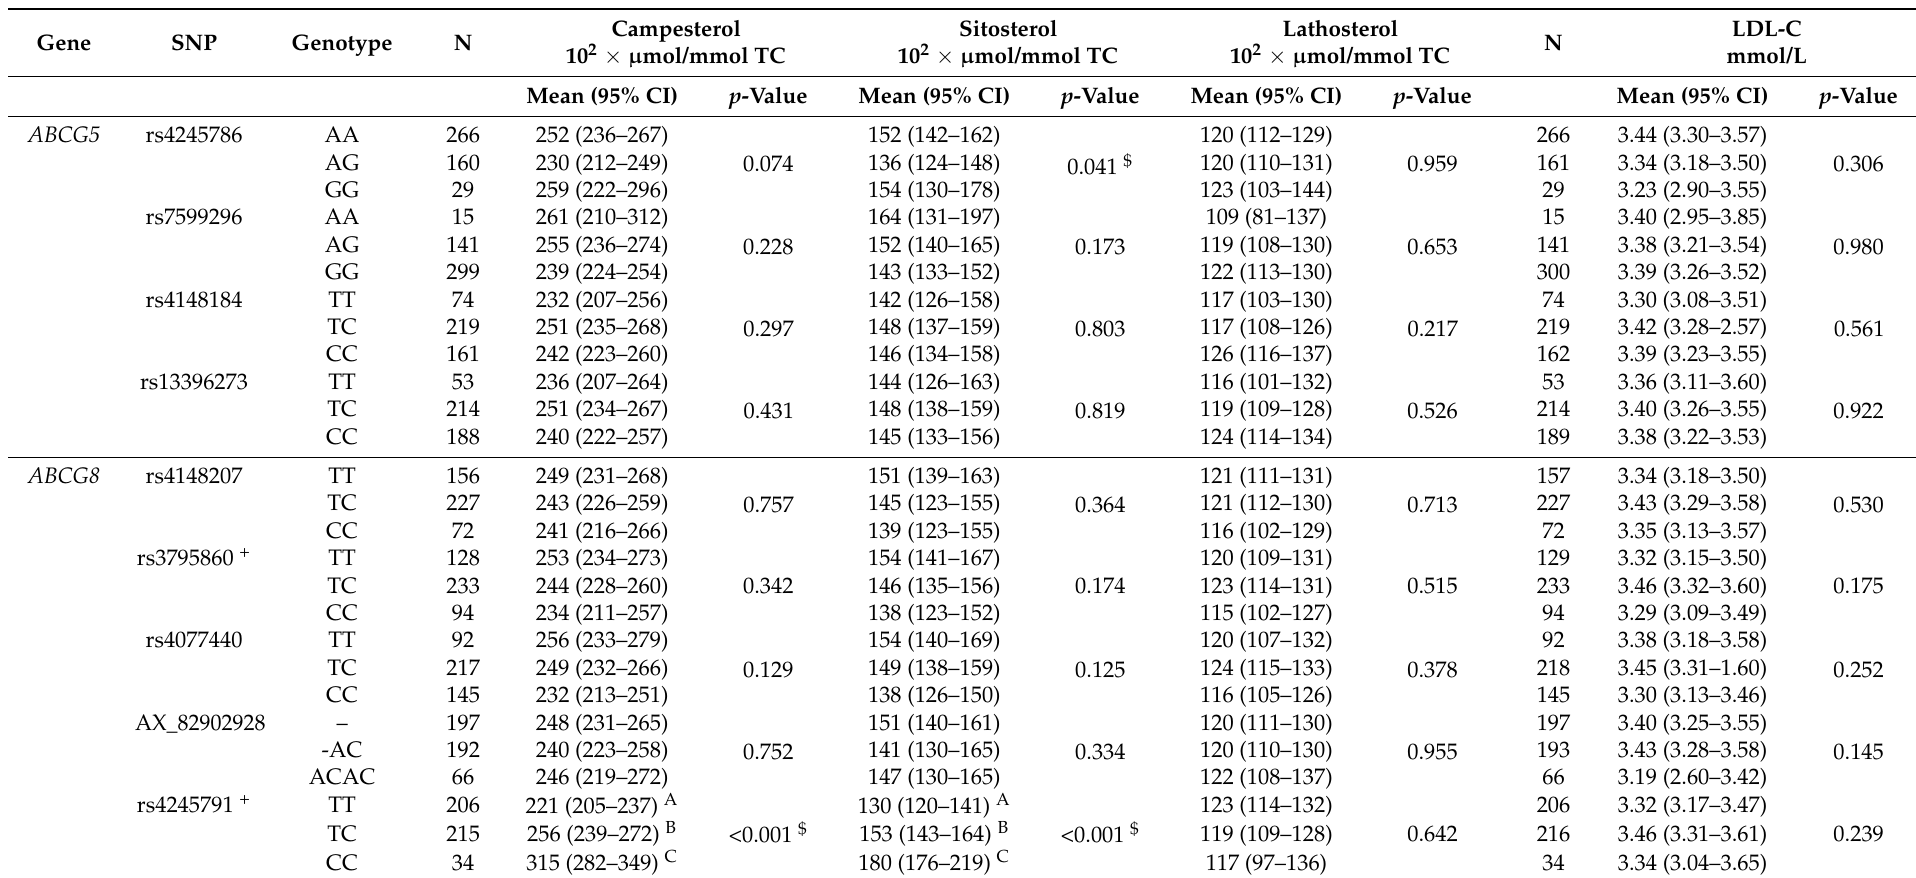
Table 2. Associations between various SNPs in cholesterol absorption genes with serum TC-standardized campesterol, sitosterol and lathosterol levels (N = 455), and serum LDL-C concentrations (N =